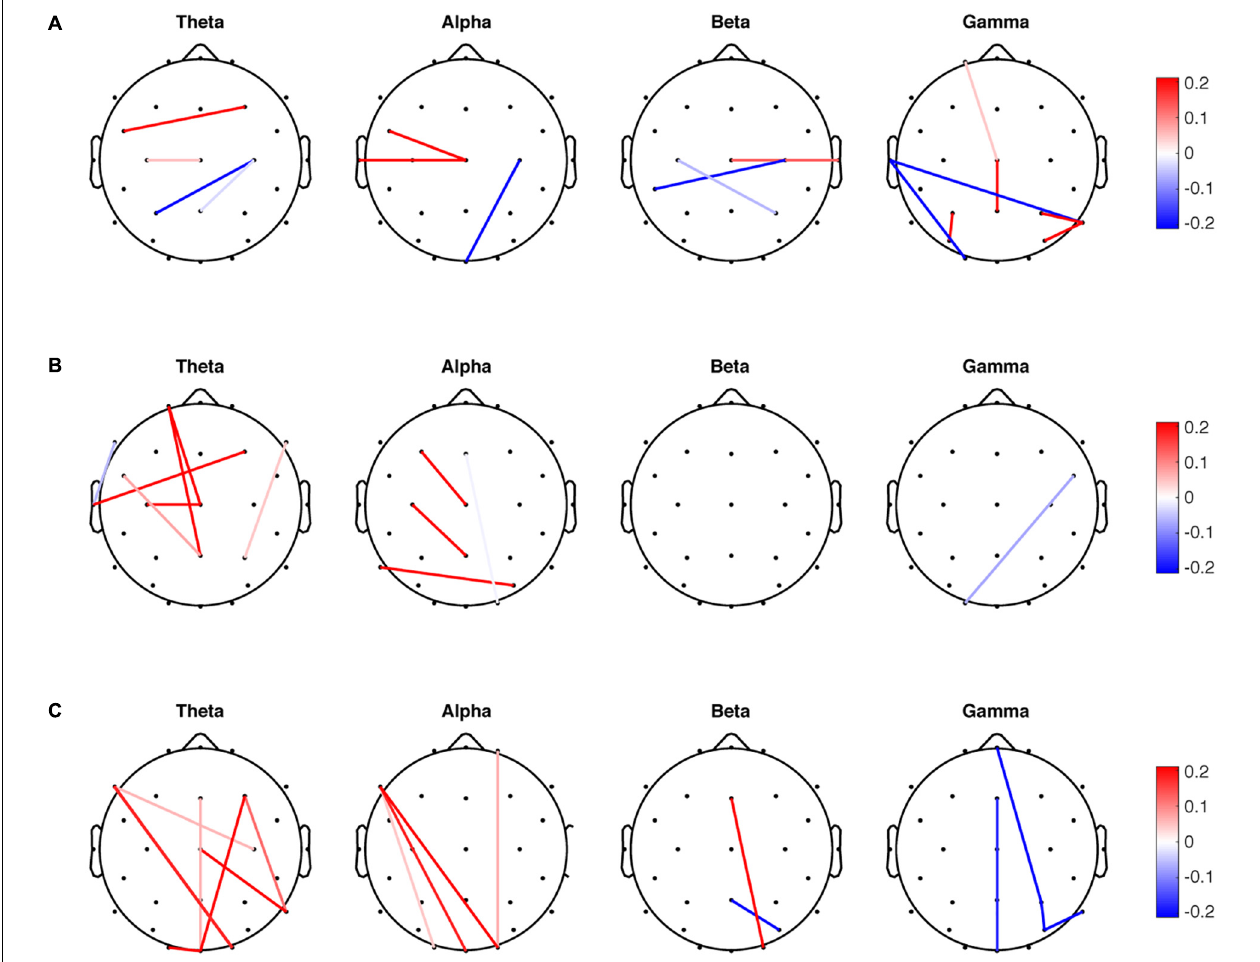
FIGURE 2 | Non-zero features selected by sparse discriminant analysis (SDA). SDA was applied to the mean, variability and entropy data sets, respectively, to discriminate the PDMOFF and HC groups. The non-zero weights in the sparse discriminant vectors are presented in the scalp maps. (A) Weights for the 17 selected features from the mean PLV data set. (B) Weights for the 12 selected features from the PLV variability data set. (C) Weights for the 17 selected features from the PLV entropy data